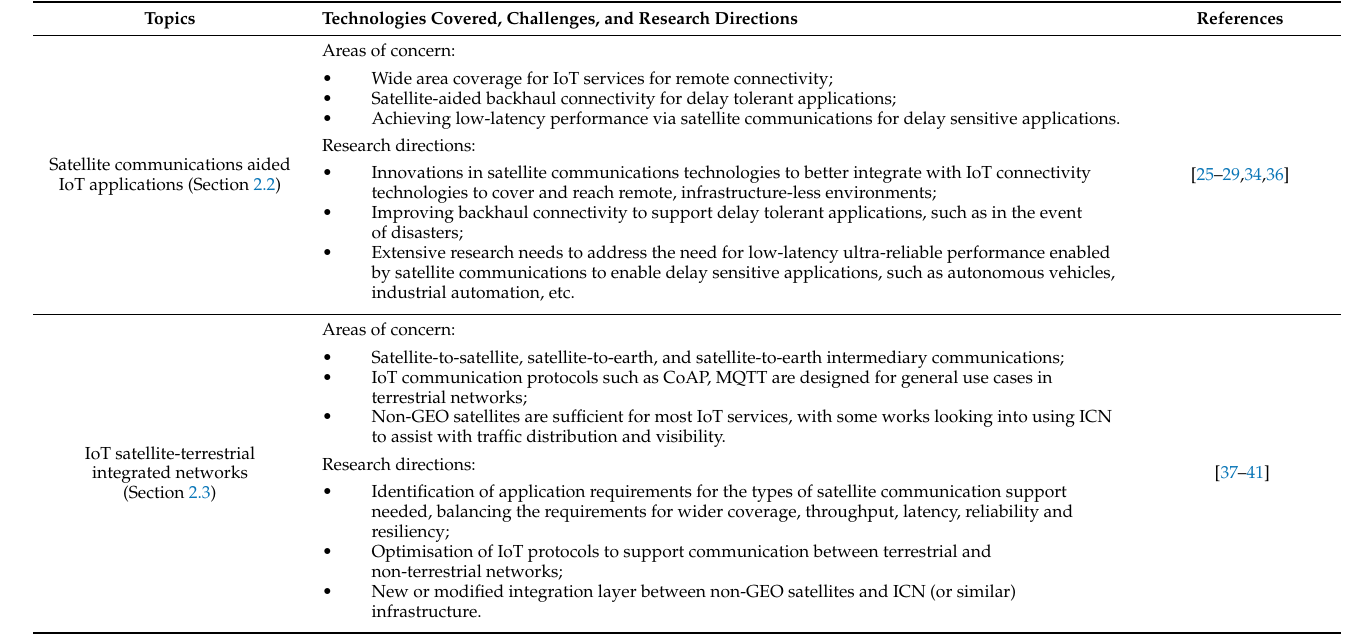
Table 1. Summary of the topics, their areas of concerns and research directions (with representative references) as described in Section